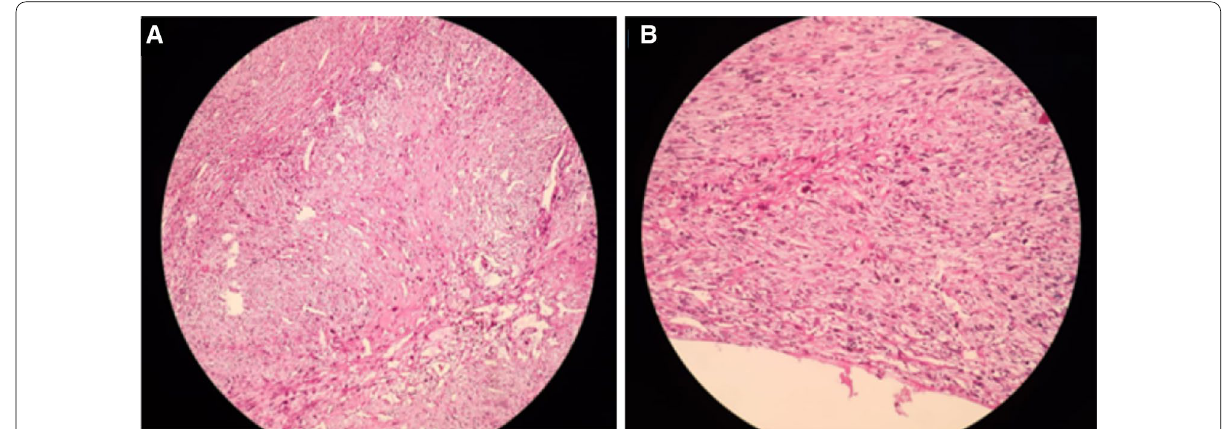
Fig. 3 Microscopic section of leiomyosarcoma of IVC with a G 10 HE ( a ) and G 20 HE ( b